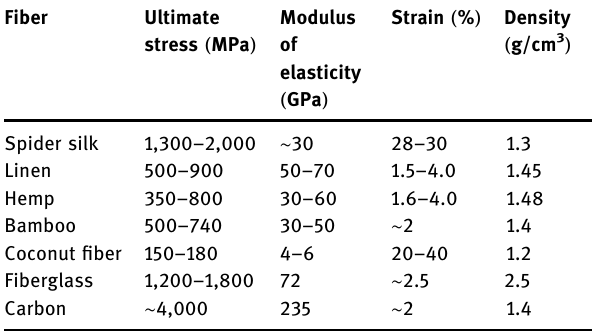
Table 1: Properties of the natural fi bers [ 8